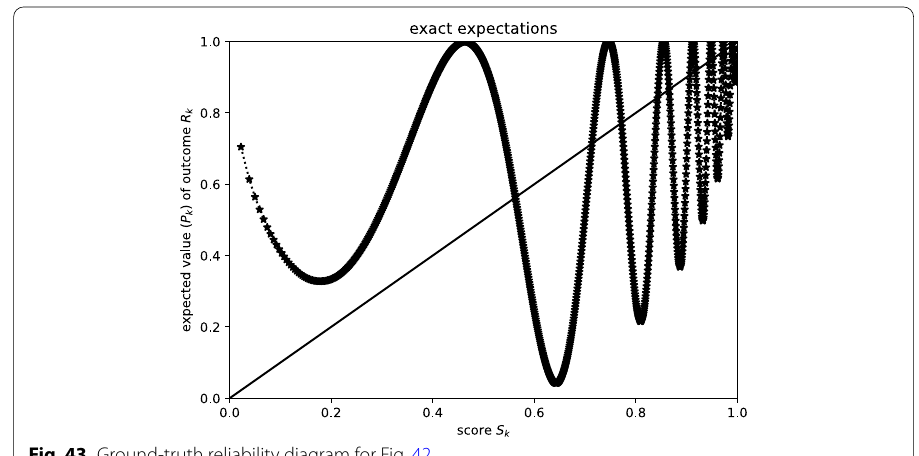
Fig. 43 Ground-truth reliability diagram for Fig.